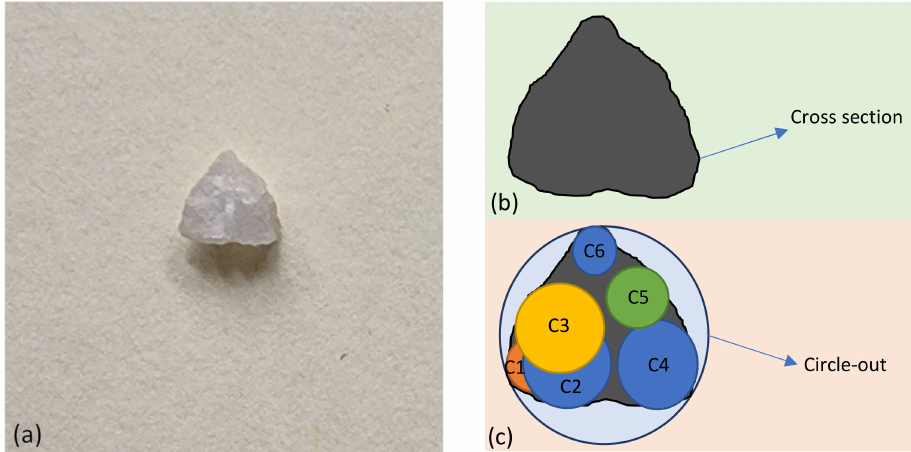
Figure 11. ( a ) Three-dimensional image, ( b ) two-dimensional cross-sectional area and ( c ) calculation of the three shape parameters S , R and ρ for one particle before cyclic testing.